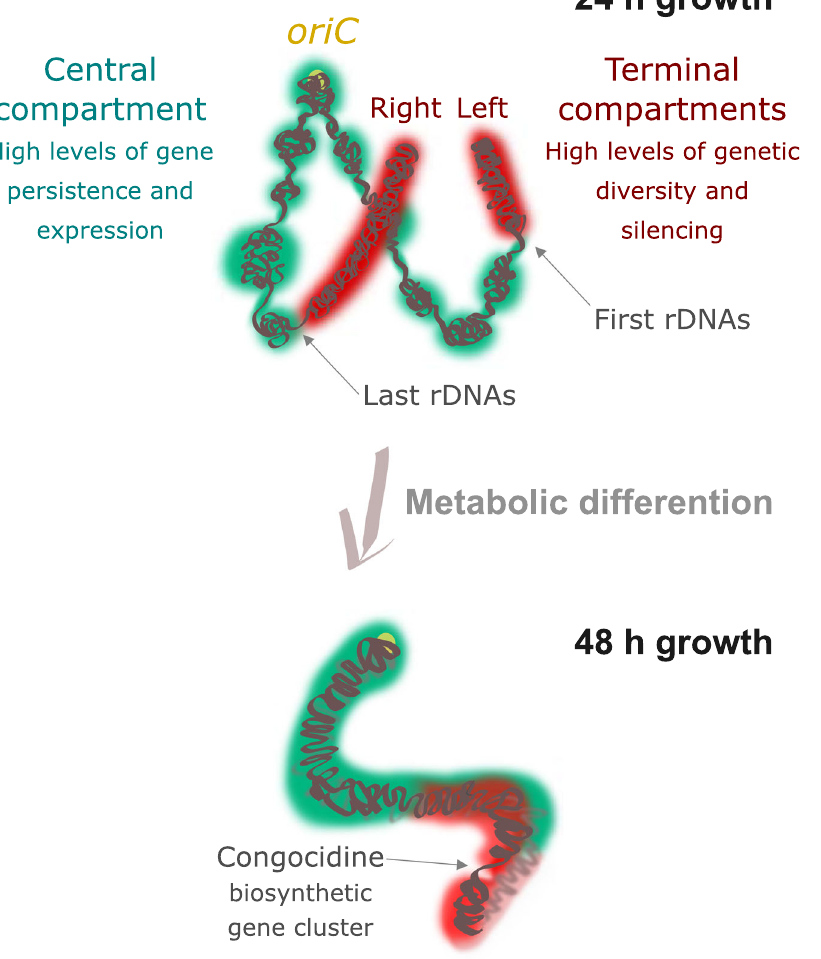
Fig. 5 Schematic representation of genome dynamics during metabolic differentiation. The Streptomyces linear chromosome is represented as green (central compartment) or red (left and right compartments). The origin of replication is indicated as a light yellow circle ( oriC ). In the exponential phase (24 h), the chromosome of Streptomyces is organized into one transcriptionally active (green) central compartment and two rather silent compartments (red). The transcriptionally active compartment is enriched in core genes and is segmented in multiple domains, fl anked by long and highly expressed conserved genes. The frequency of contacts is not signi fi cant enough to de fi ne a genuine secondary diagonal, but the signi fi cant contacts highlight a domain encompassing the origin of replication (Supplementary Fig. 5f). The low frequency of contacts between the two arms is represented as a rather open conformation of the chromosome. After 48 h of growth, the transcription of the congocidine BCG is accompanied by a global rearrangement of the chromosome. The increase in the frequency of contacts between the two chromosomal regions around the origin is represented as a closed conformation (Supplementary Fig. 5f). Note that the inter-arms contacts observed in the stationary phase decrease toward the terminal ends (Supplementary Fig. 5f). In addition, since TIRs cannot be distinguished at the sequence level, they were neither considered in this analysis nor represented in this fi gure. However, they may be located close to each other 87 , although this remains controversial 88 . This model is based on the 3C-map contacts of Fig. 4 and its 3D-models generated by ShRec3D software 82 (Supplementary Fig.